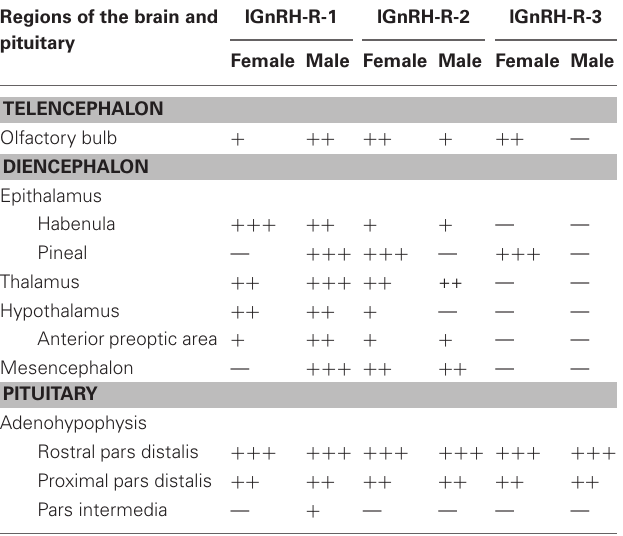
Table 3 | Results of lGnRH Receptor-1, -2, and -3 RNA expression in the brain of female/male adult sea lamprey by in situ hybridization. Regions of the brain and